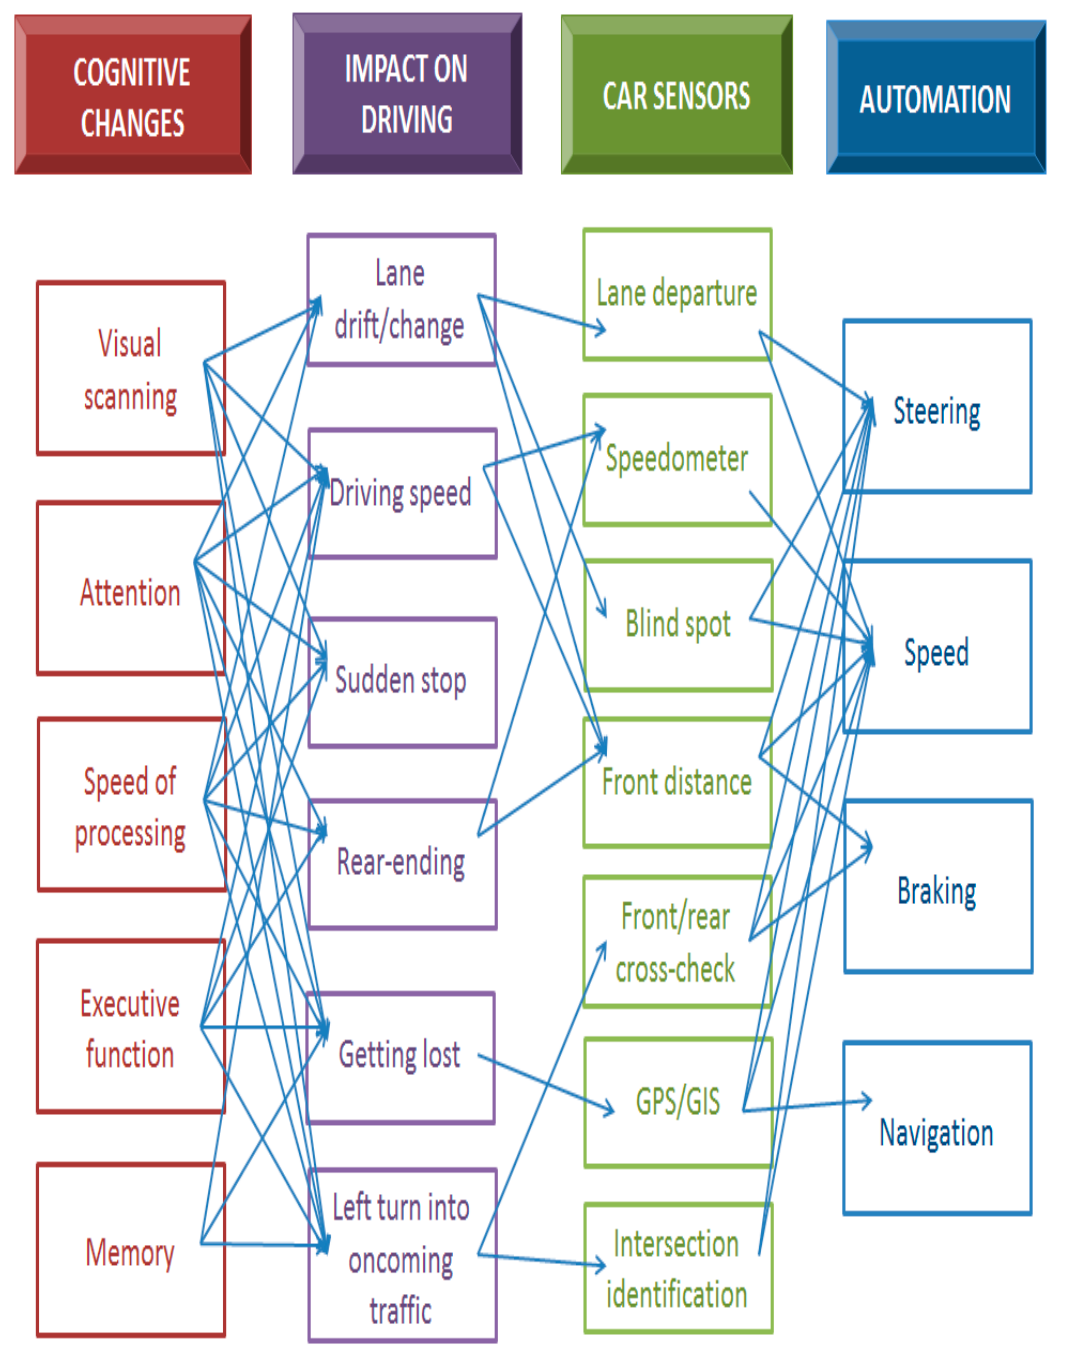
Figure 1. A complex model of connections between driving changes associated with cognitive decline and vehicle automation.